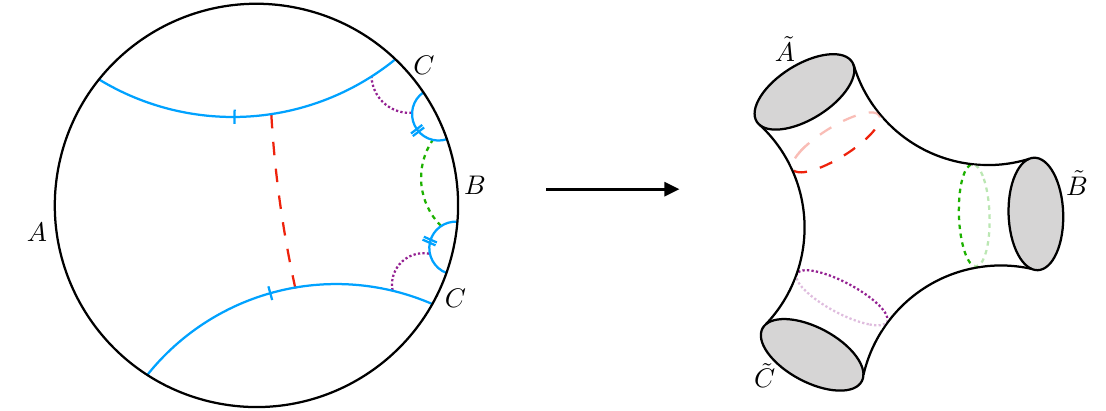
Figure 7 . The two di(cid:11)erent pairwise surface identi(cid:12)cations used to make the three-sided worm- hole geometry. Single or double notches indicate the identi(cid:12)cations of pairs of blue surfaces in the left sub(cid:12)gure, creating the wormhole geometry depicted in the right sub(cid:12)gure. The minimal surfaces that connect pairs of identi(cid:12)ed geodesics (depicted here by dashed lines of di(cid:11)ering colors and weights) map onto the respective horizon areas (shown with the same dashed lines) in the wormhole